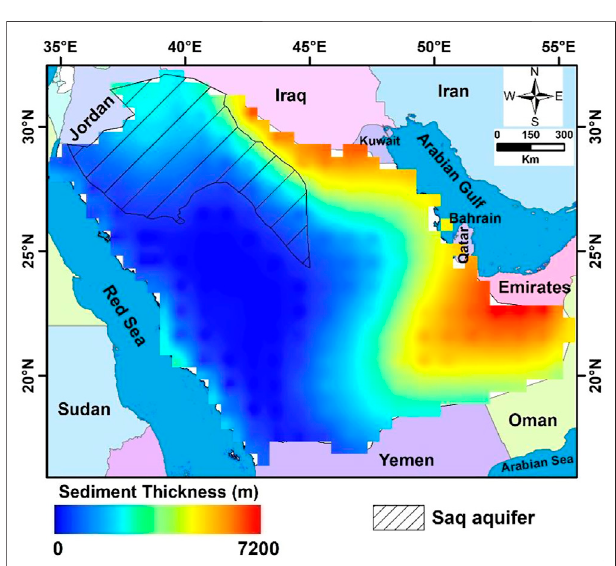
FIGURE 16 | Sediment thickness map (m) in the study